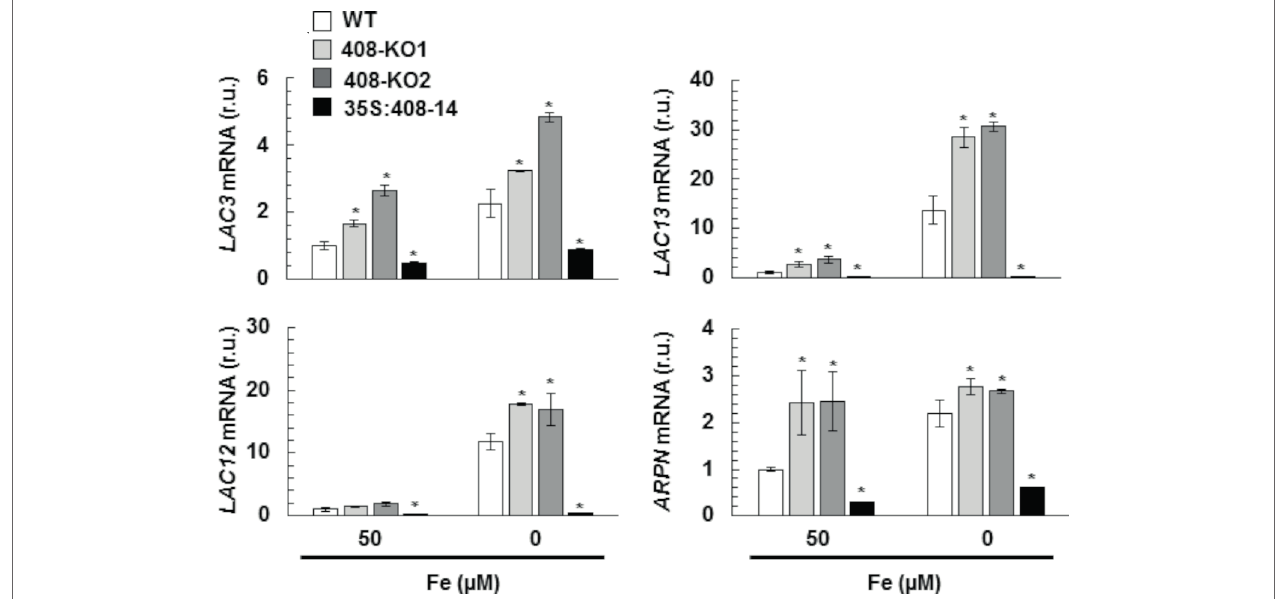
FIGURE 3 | Gene expression of the miR408 targets under iron deficiency. LAC3, LAC12, LAC13, and ARPN relative expression. The 15-day-old wild-type (WT), 408-KO1, 408-KO2, and 35S:408-14 seedlings grown in 1/2 MS medium containing 50 and 0 μ M Fe citrate. Total RNA was extracted and analyzed by RT-qPCR with specific oligonucleotides for LAC3, LAC12, LAC13 , and ARPN. The UBIQUITIN10 gene was used for data normalization, and the expression is shown in relative units (r.u.). Values correspond to the arithmetic means (2 −∆∆Ct ) ± standard deviation of at least three biological replicates ( n ≥ 25 plants). Asterisks denote significant differences for the same group of samples compared to the WT line ( p < 0.05) based on the pair-wise fixed reallocation randomization test.